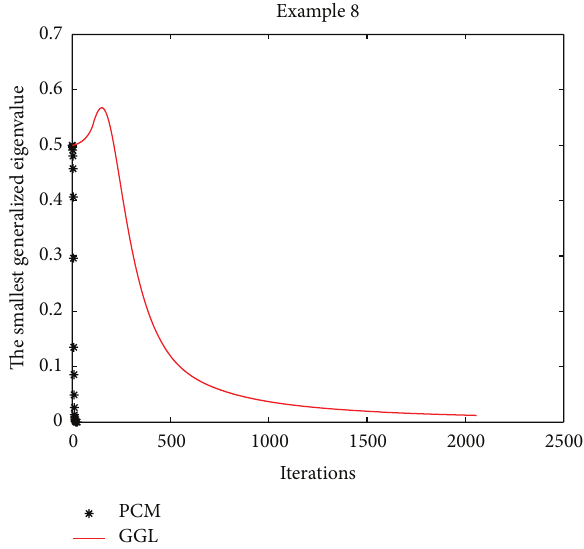
Figure 4: Numerical results of Example 8 with PCM and GGL methods.